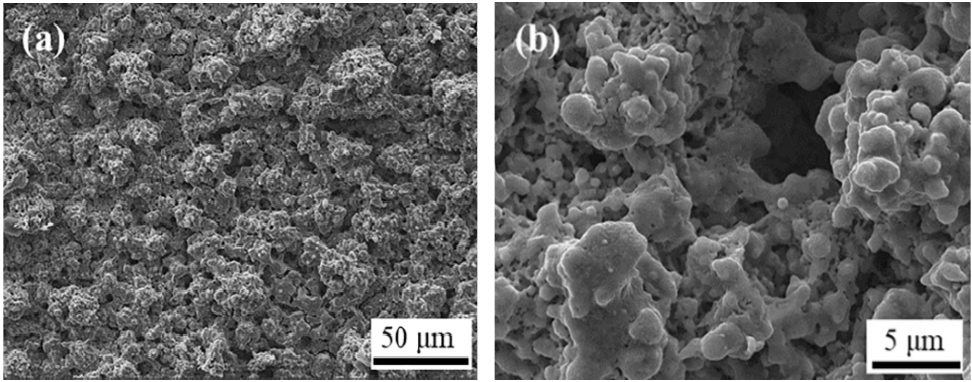
Figure 4. Surface morphology of the YSZ/LSM composite cathode after annealing treatment at 1050 °C for 2 h: ( a ) Low magnification. ( b ) High magnification.